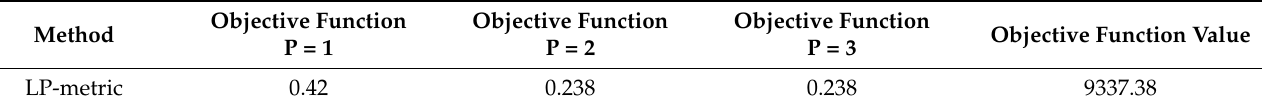
Table 18. The exact solution of the model obtained by the Lp-Metric